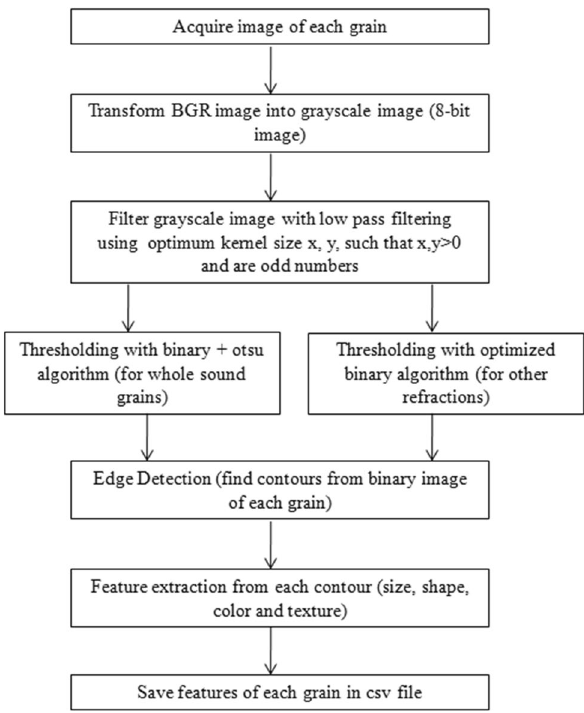
Figure 1. Flow diagram for features extraction from acquired